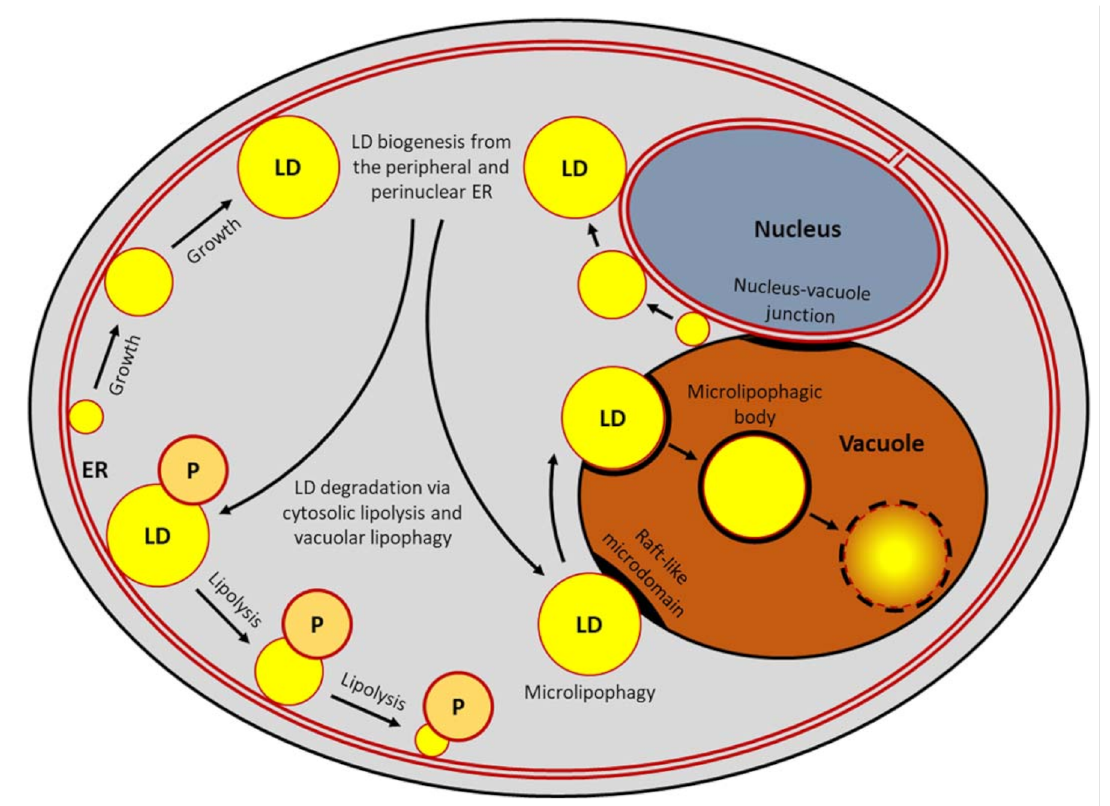
Figure 1. Pathways that contribute to lipid droplet homeostasis in yeast. Lipid droplet (LD) homeostasis is the sum of the anabolic (LD biogenesis from the peripheral and perinuclear endoplasmic reticulum (ER)) and catabolic (LD degradation via cytosolic lipolysis and vacuolar lipophagy) processes. Under nutrient-rich conditions and absence of stressors, yeast cells possess a few small LDs associated with the ER. Starvation for carbon or nitrogen source induces LD biogenesis from the ER membranes, especially the nucleus–vacuole junction. The LDs grow and remain associated with the ER. During prolonged starvation, they can either be degraded in the cytosol by the LD-associated lipases or undergo microlipophagy and degradation in the vacuole by the vacuolar lipases and proteases. During lipolysis, LDs can be associated with peroxisomes where fatty acids from LDs are metabolized via β -oxidation. Microlipophagy involves vacuolar docking of LDs at the newly formed raft-like microdomains followed by internalization of LDs via invagination and scission of the vacuolar membrane, and formation of the intravacuolar microlipophagic bodies that are subsequently disintegrated by the vacuolar hydrolases. P,